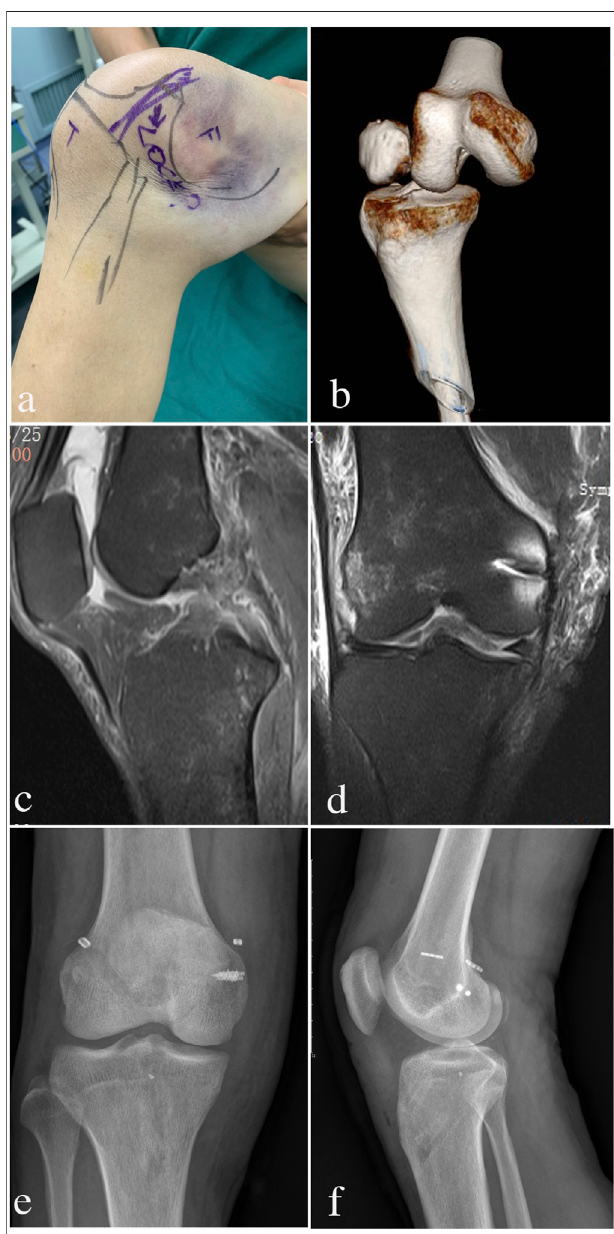
FIGURE 1 | Evolution process of IKD patient appearance and imaging examinations from injury to postoperative follow-up. (A) “ Dimple sign ” and severe ecchymosis with invagination of skin and soft tissue can be observed on the medical side; (B) before the stage-1 operation, CT showed the knee posterolateral dislocation; (C) : before stage-2 operation, MRI showed that the MCL structure had been repaired; d: before stage-2 operation, MRI showed the ACL and PCL rupture; (E,F) : X-ray showed normal knee alignments at 0.5 years and 1 year follow-up.